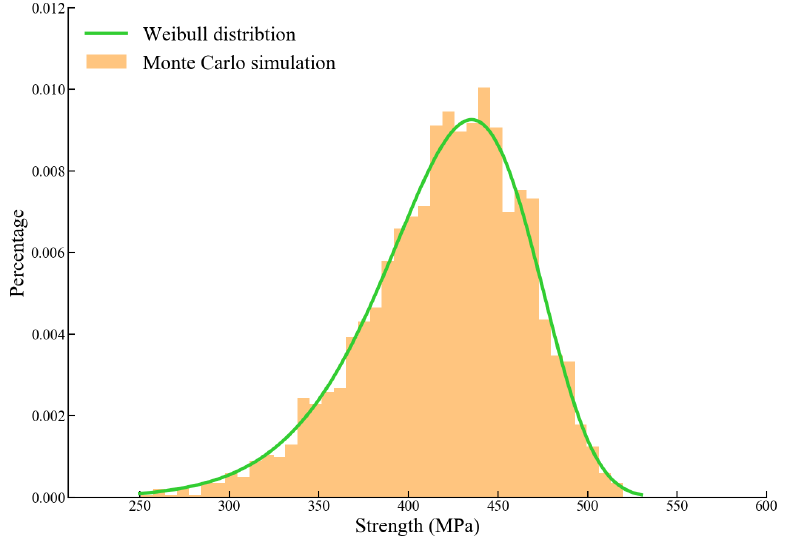
Figure 2. The green line is Weibull’s statistical strength distribution of cohesive elements obtained from Equation (8) with m 0 = 11.0, m a = − 11.0, σ 0 = 440.0, A = 0.01268 and A 0 = 0.013. The orange bar is the statistics of the facet strength of the cohesive element with random flaws generated by Monte Carlo simulations. The percentage of low-strength cohesive elements (below 350 MPa) is around 7.9%, which is associated with the big flaws in the material. The rest of the cohesive elements (around 92.1%) have strong strength (between 350 and 530 MPa), which corresponds to the material with smaller